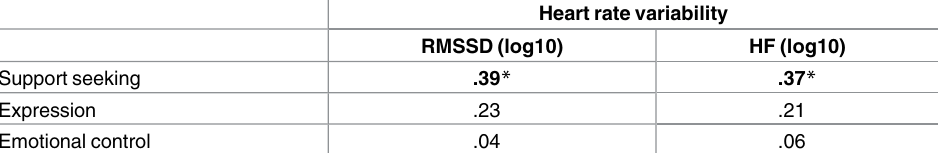
Table 3. Follow-up correlations between heart rate variability and the subscales of external emotion